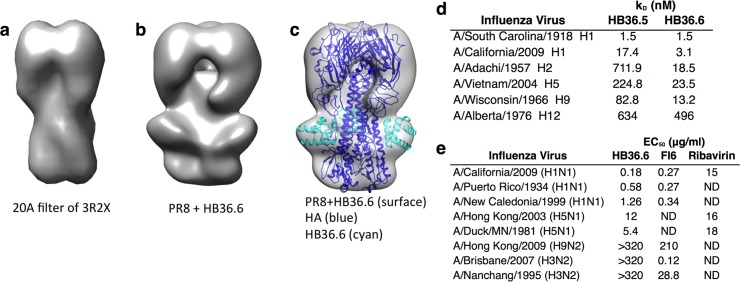
Characterization of HB36.6.(a) Crystal structure of A/South Carolina/1/1918 (H1) HA (derived from PDB 3R2X) filtered to 20 Å resolution. (b) Negative-stain EM reconstruction of PR8 HA bound to HB36.6. (c) X-ray structure of A/South Carolina/1/1918 (H1) HA (PDB 3R2X) (blue) in complex with HB36.6 (cyan) docked into PR8 EM reconstruction in b. HB36.6 fits well into the extra density in the stem region. (d) Equilibrium binding constants determined by biolayer interferometry for HB36.5 and HB36.6 against six HAs demonstrate broad improvements against a variety of Group 1 subtypes. (e) EC50 (μg/ml), compound concentration that reduces viral replication by 50%, of HB36.6, the monoclonal antibody FI6v3, and ribavirin against five representative strains from H1, H9, and H5 Group 1 viruses and two H3 Group 2 viruses. ND: not determined.